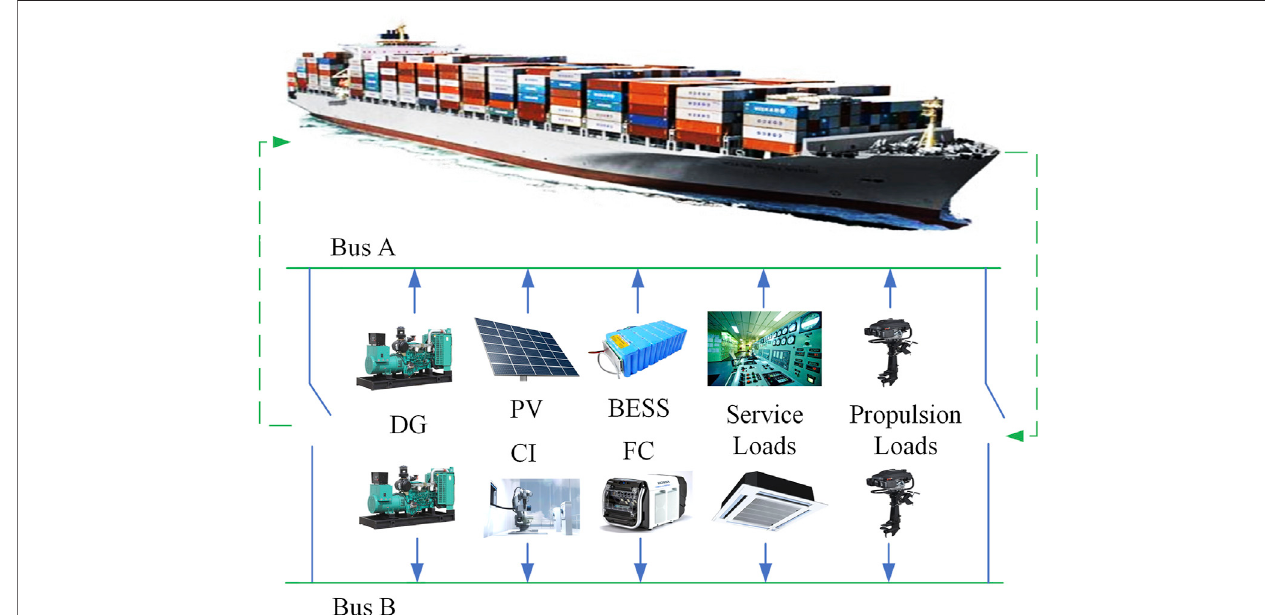
FIGURE 1 | Topology of the proposed AES.